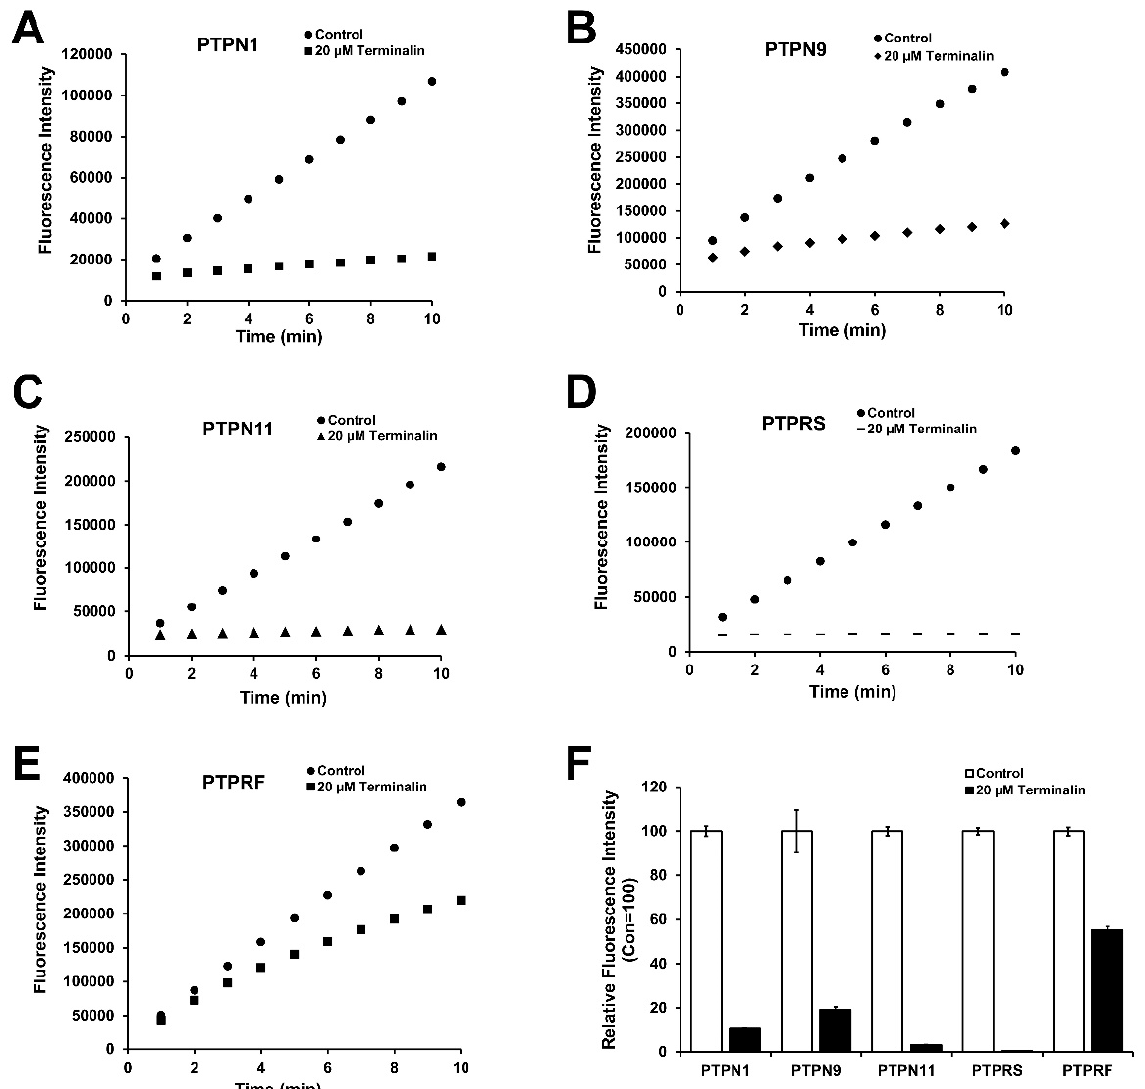
Figure 3 . Terminalin inhibits the catalytic activity of PTPs. ( A – E ) The catalytic activities of PTPs against terminalin were measured using DiFMUP, a widely used PTP substrate. Progress curves showing catalytic activity of PTPs by 20 μ M terminalin and control. ( F ) Relative fluorescence intensity of PTPs against terminalin and control.